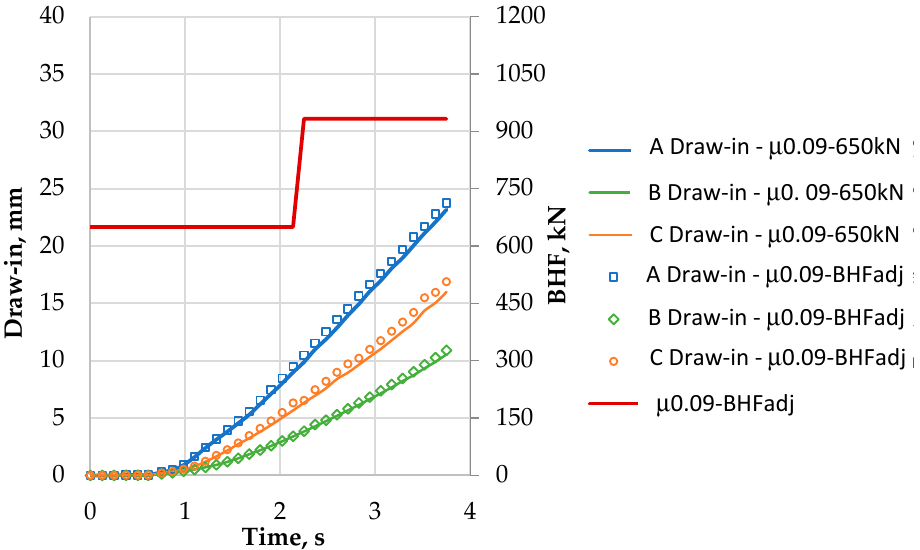
Figure 21. Results after BHF adjustment for µ = 0.09 in terms of draw-in and BHF adjustment curve.